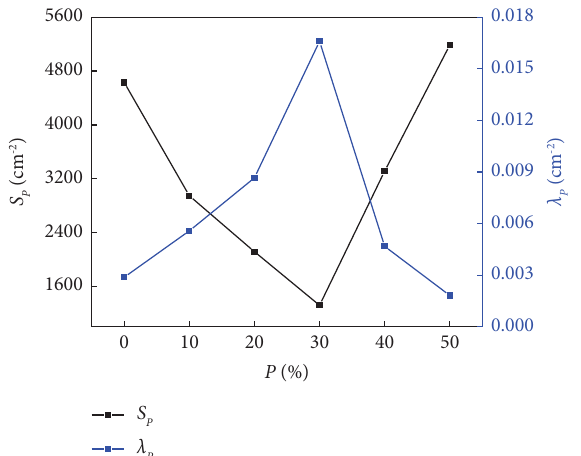
Figure 15: Change curves of surface area and surface specifc energy with fy ash content.